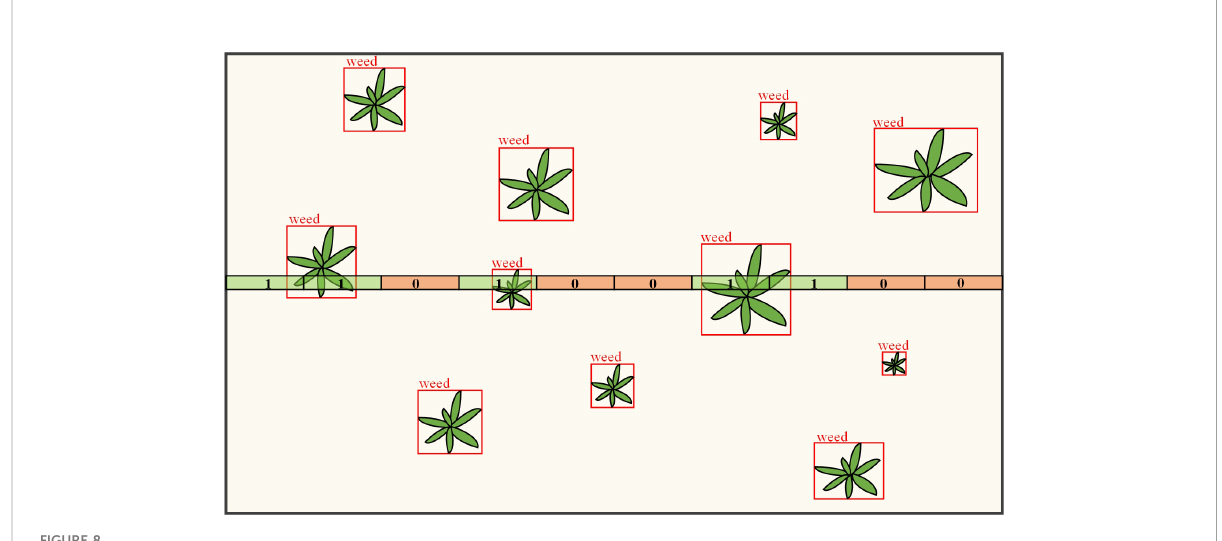
FIGURE 8 Schematic diagram of grille decision